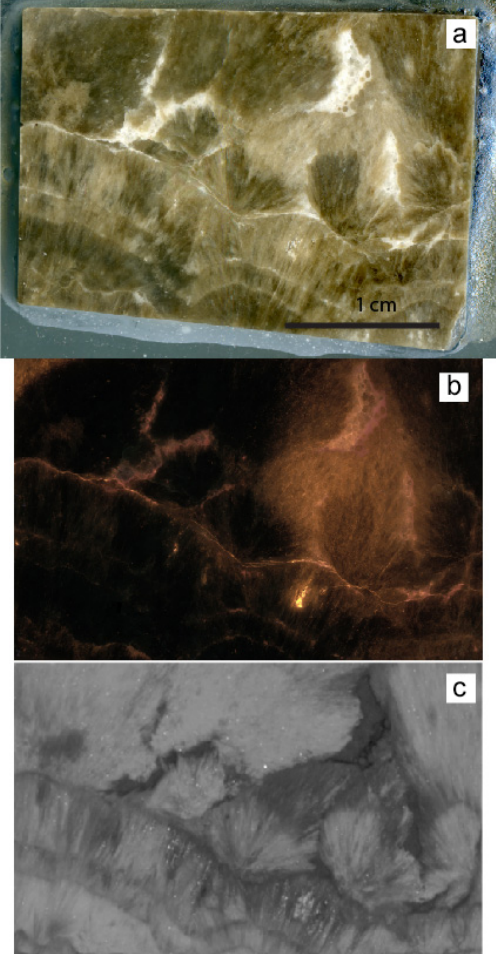
Figure 3. (a) Polished slab from the Walnut Canyon Neptunian Dike sample used in this study to illustrate various tools for char- acterization. This is approximately 3cm across. This is a similar size to that being distributed as a reference material (Roberts et al., 2017). Note the variability of color from very dark to light brown and the white veins. The fibrous botyroidal texture is visible even at this scale, and complexities due to veins should be easily avoided when using this as a LAcarb reference material. (b) Photomosaic of 639 CL photos. (c) MicroXRF map of Sr (details in the next figure caption). Areas that are brightly luminescent have low Sr. Bound- aries between botryoid layers are luminescent (and white so they are easy to avoid) and should be avoided when using this sample as a standard. This microXRF map of Sr beautifully shows the texture of the sample. We suggest that this easy screening technique could be done on all slabs being used for a LA standard and that using this as a guide for analyses could result in better reproducibility of